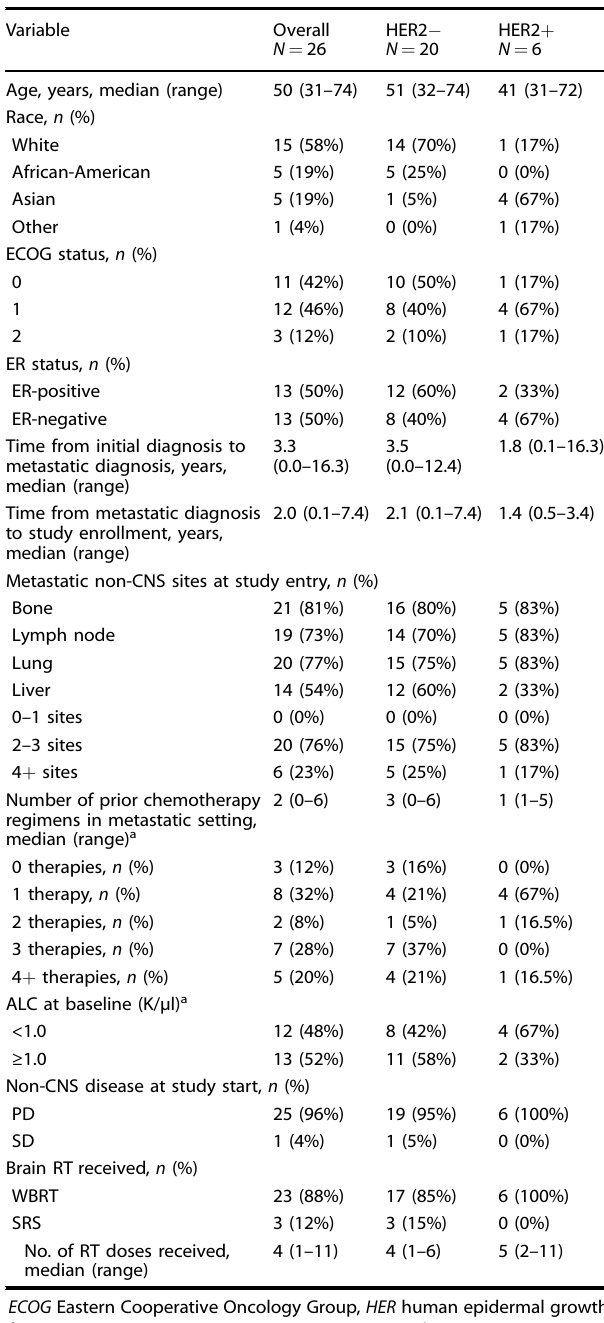
Table 1. Patient